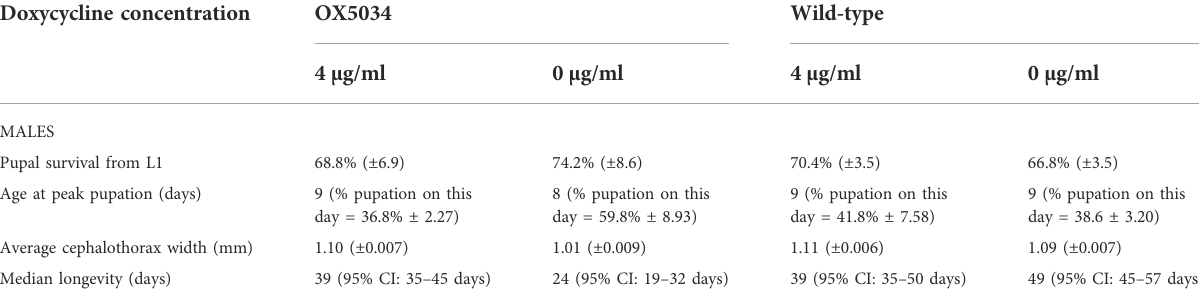
TABLE 2 Comparison of average male pupalsurvival (assuming1:1 sexratio),peak pupation,cephalothorax widthand adultlongevity ofOX5034and WT strains reared under controlled laboratory conditions with and without 4 μ g/ml doxycycline (±95% Con fi dence